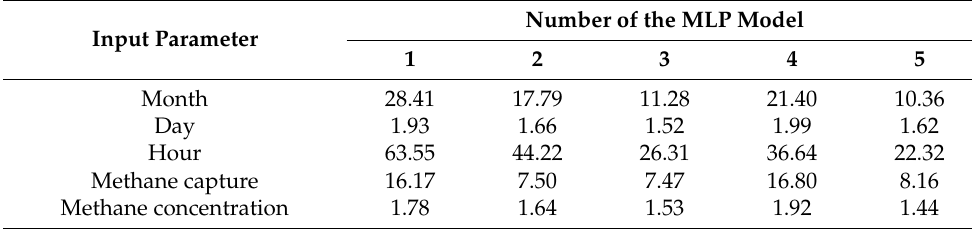
Table 8. Sensitivity analysis of variables.